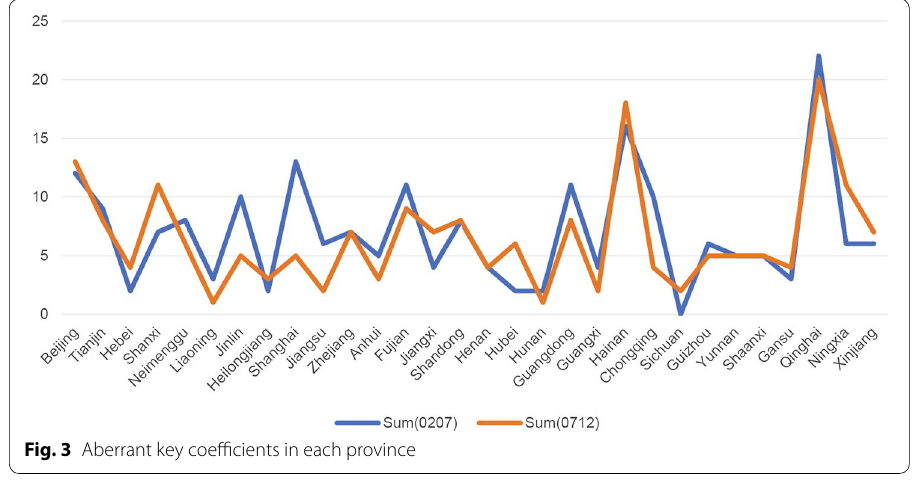
Fig. 3 Aberrant key coefficients in each province